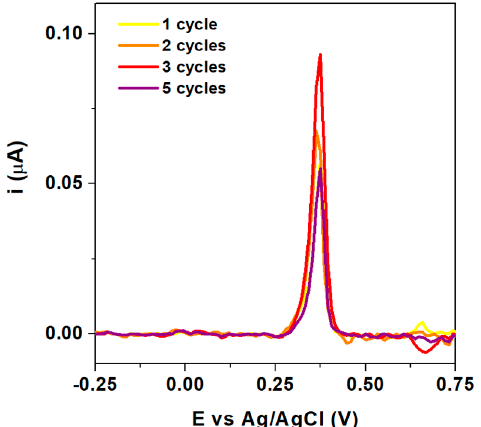
Figure 7. DPV curves (background corrected) recorded in a solution containing 5 × 10 − 8 M Hg(II) on GC|click| L modified electrodes prepared using different number of scans during grafting with diazonium salt.